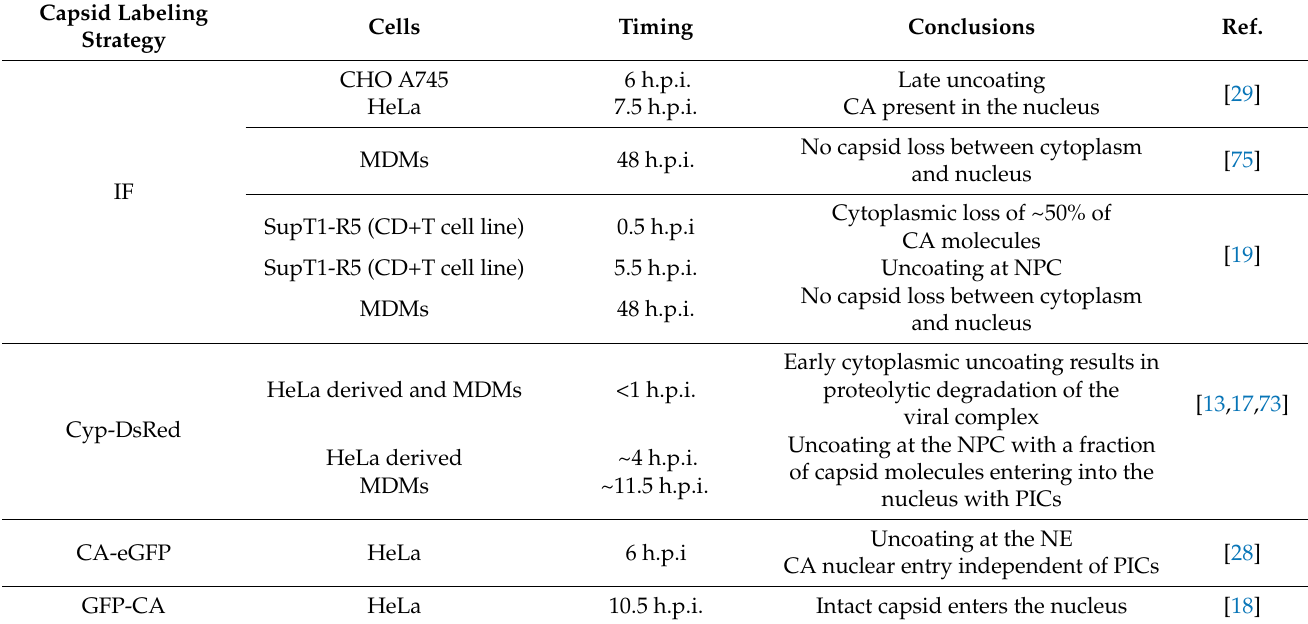
Table 2. Summary of the main conclusions of uncoating studies with respect to the labeling strategy used. (h.p.i. hours post infection) Capsid Labeling Cells Timing Strategy